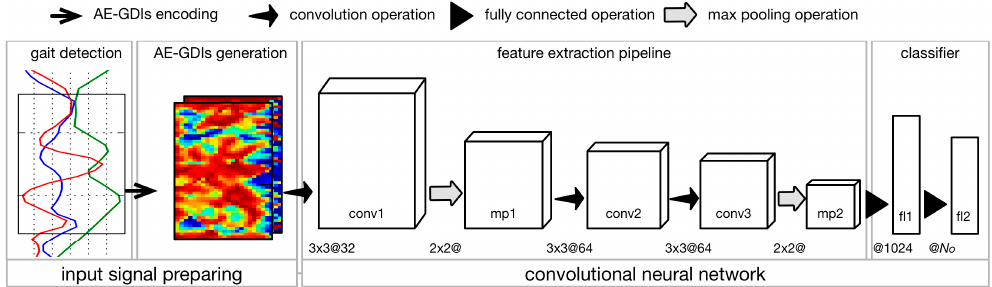
Figure 1. The workflow of the proposed gait recognition approach, which consists of four main modules connected sequentially, namely, gait detection, AE-GDIs generation, feature extraction pipeline, and classifier. The feature extraction pipeline and classifier constitute a complete convolutional neural network. The operations corresponding to different arrows are illustrated above the workflow. Note that “conv”, “mp” and “fl” are the abbreviations of “convolutional layer”, “max pooling layer” and “fully connected layer” respectively. The numbers before “@” refer to the kernel parameters of the corresponding operation and the number after “@” refers to the number of feature maps in convolutional layers, or the output dimension of the fully connected layers.